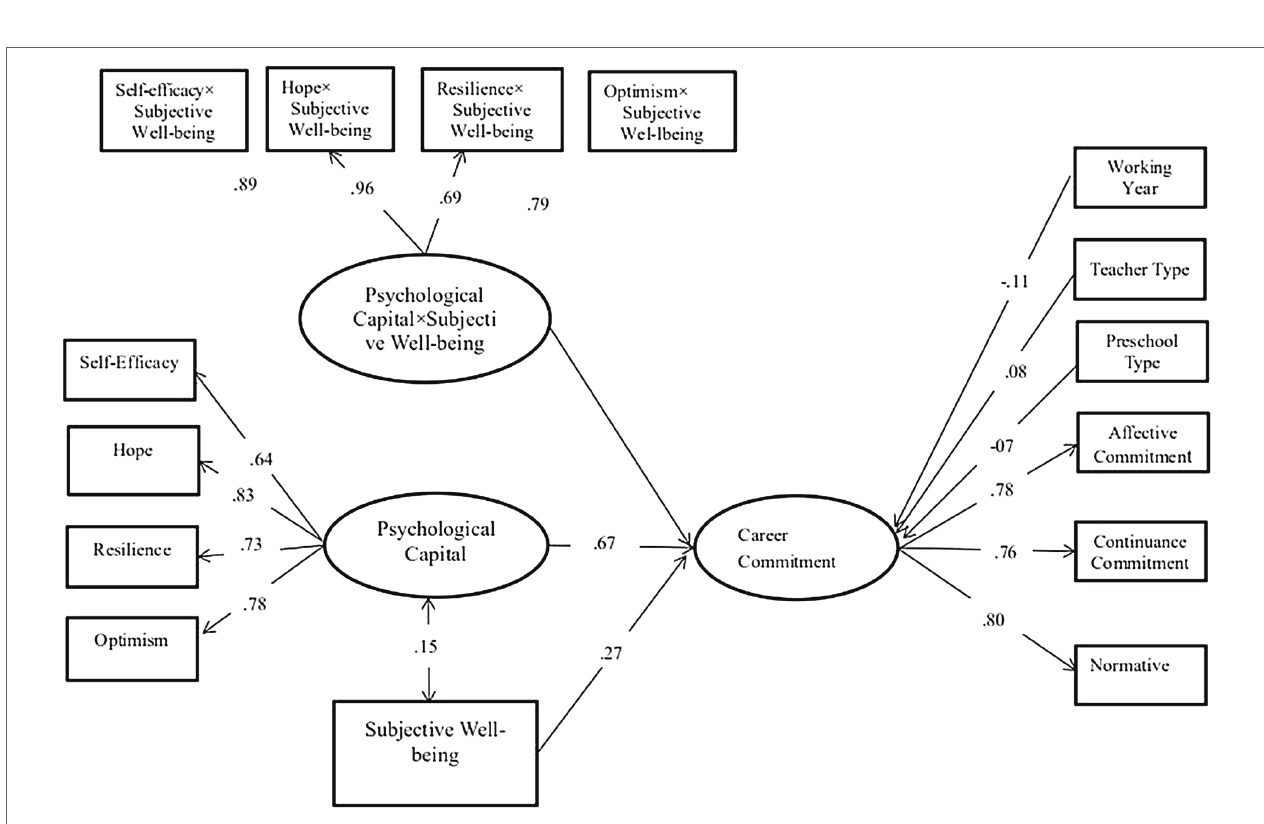
FIGURE 2 | Associations between psychological capital (PsyCap), subjective well-being (SWB), and occupational commitment ( N = 759).